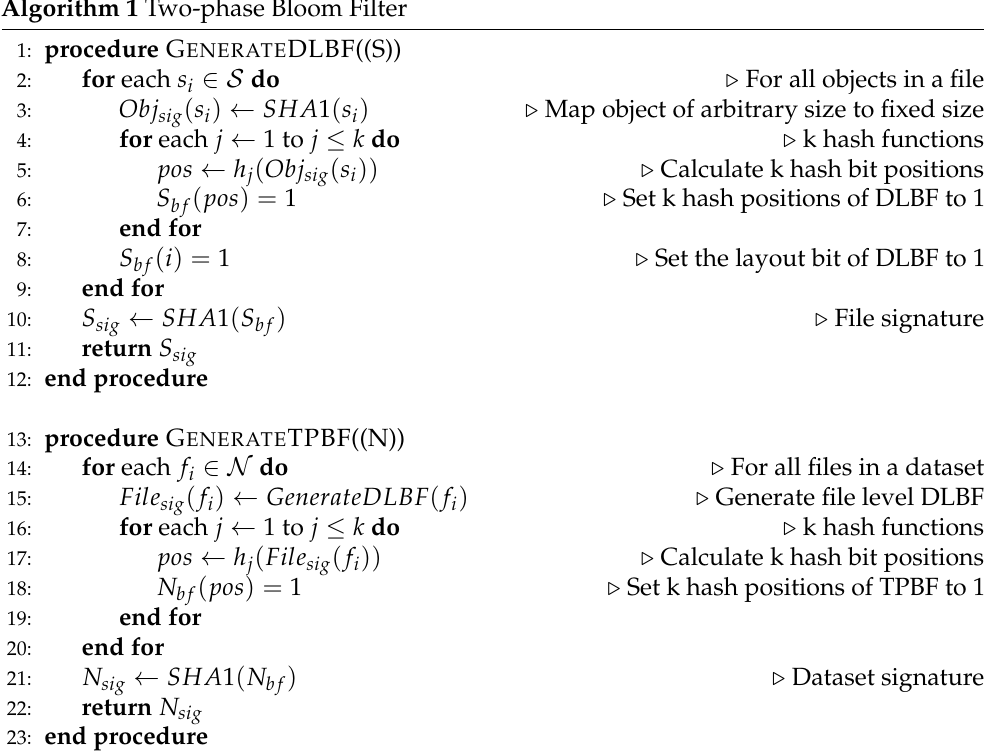
Algorithm 1 Two-phase Bloom